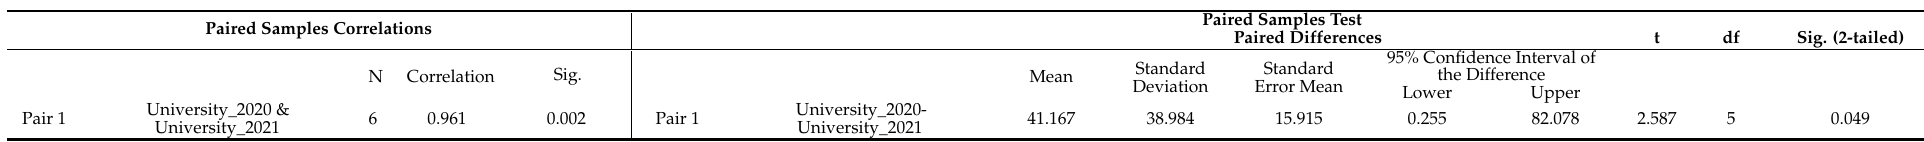
Table 28. Paired samples t-test applied for the perspective of students in two different academic years exam sessions on different methods of conducting an exam. Paired Samples